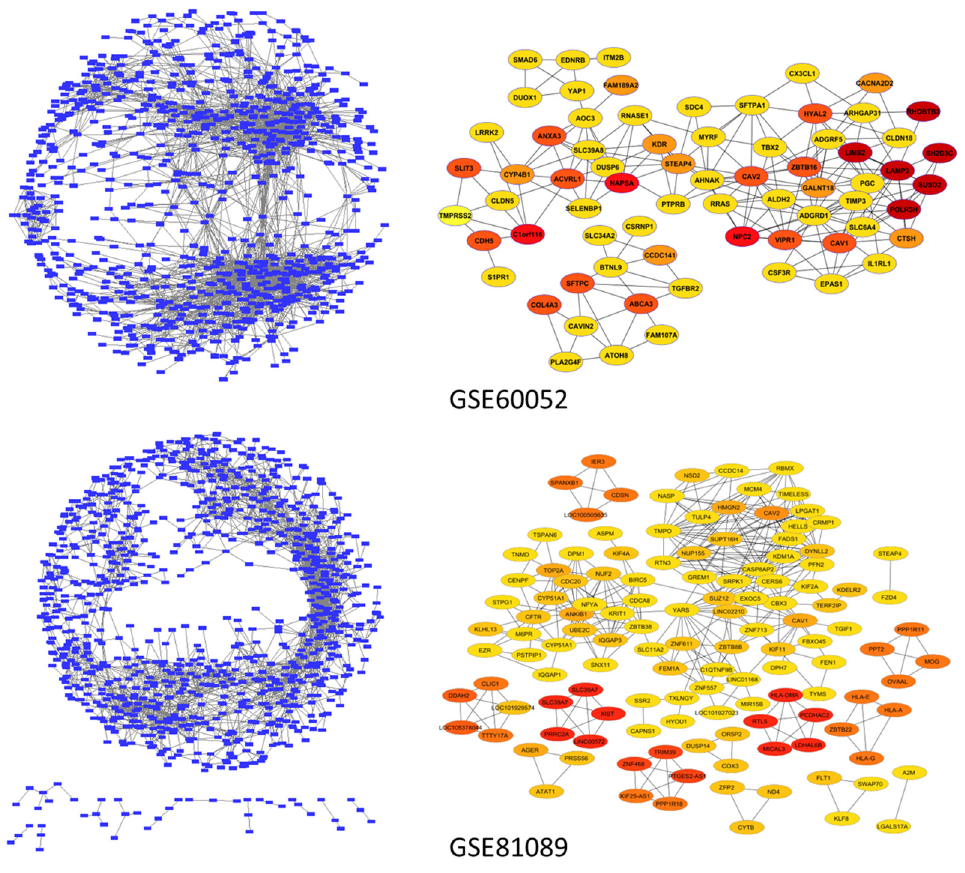
Figure 2. Network diagrams for the 2 datasets: figures on the left side represent the network before filtering while those on the right show the networks after filtering with maximal clique. On the filtered networks, different colors denote expression levels with red color showing features that were highly expressed.